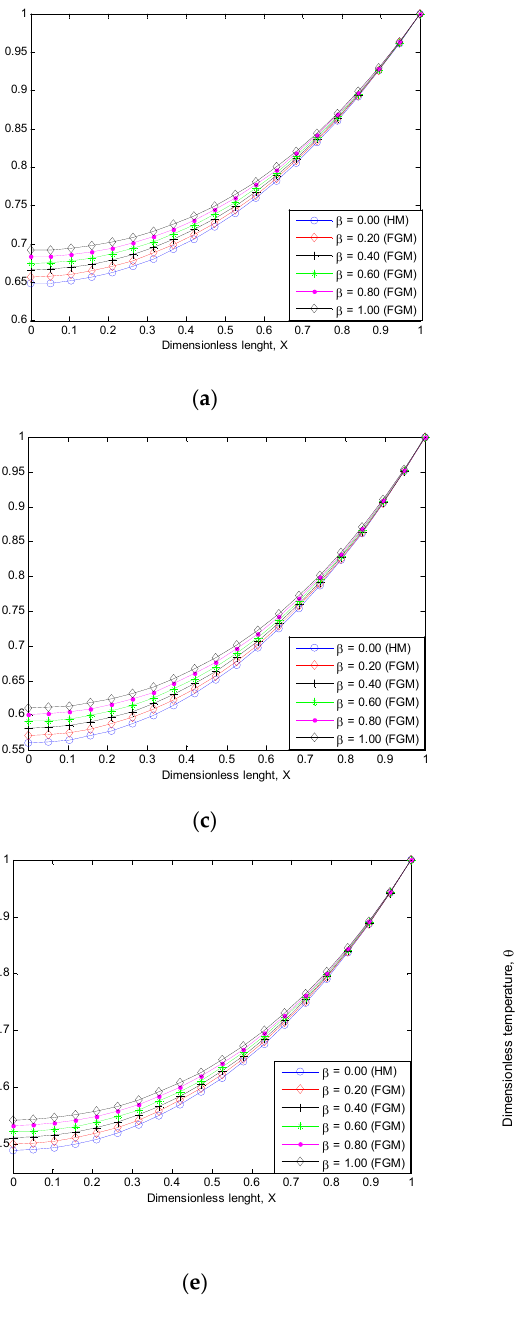
Figure 2. Fin dimensionless temperature profile for varying thermo-geometric parameter under linear-law function when: ( a ) Nr = 0.0, Ra = 0.01, Nc = 1.0; ( b ) Nr = 0.2, Ra = 0.01, Nc = 1.0; ( c ) Nr = 0.1, Rd = 0.01, Nc = 1.0; ( d ) Nr = 0.1, Ra = 0.01, Nc = 1.2; ( e ) Nr = 0.1, Ra = 0.01, Nc = 1.5; and ( f ) Nr = 0.2, Ra = 0.01, Nc = 1.2.